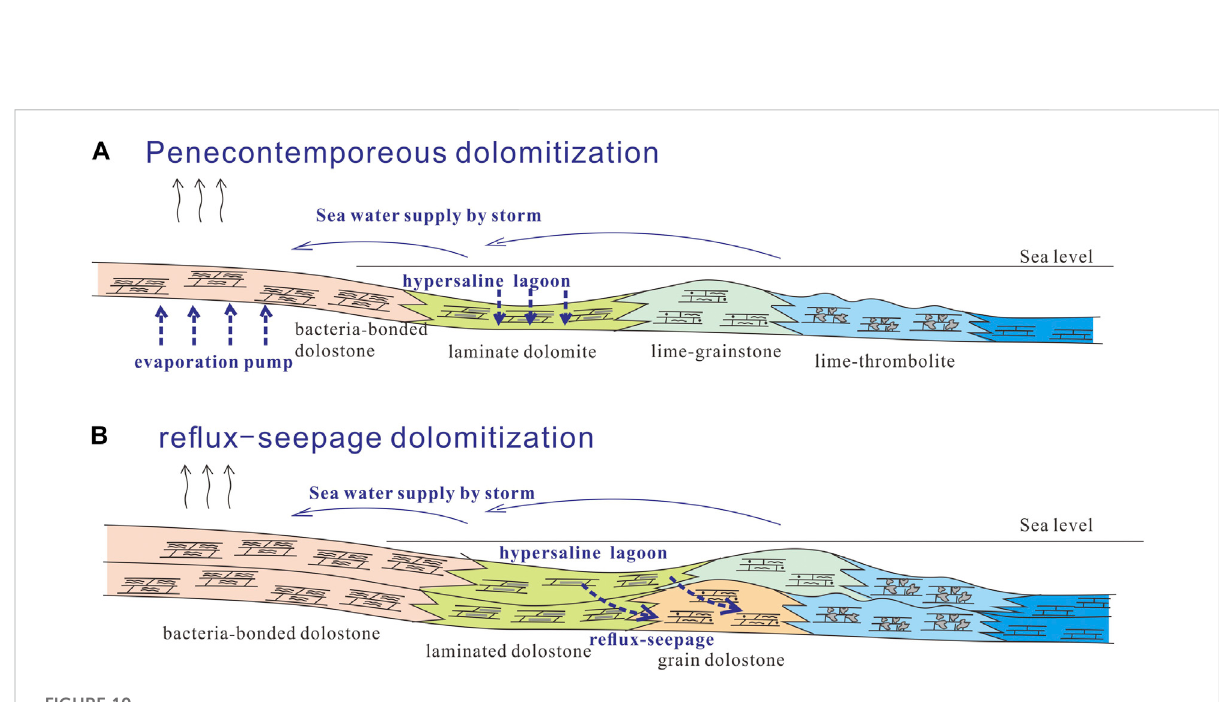
FIGURE 10 The dolomitization models for the Xiaoerbulake Formation in the well XKD-1 in the northwest of the Tarim Basin. (A) Penecontemporeous dolomitization for the bacteria-bonded dolostone and laminate dolomite. (B) Re fl ux-seepage dolomitization for grain dolostone and thrombolite